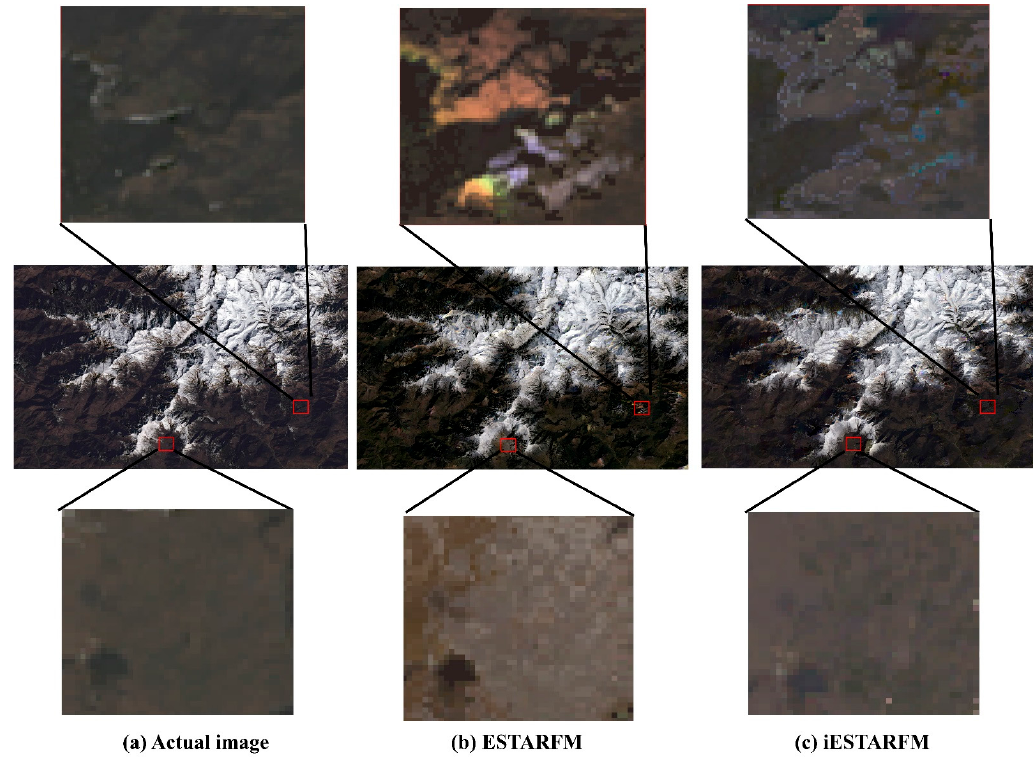
Figure 7. Comparison of the actual and predicted images. ( a ) is the actual image observed on 12 February 2020. ( b ) is the prediction image by ESTARFM. ( c ) is the prediction image by iESTARFM. The images of the first and third rows are the zoom-in areas of three images. From the visual comparison of the overall image, the predicted snow cover bounda- ries of the two methods are similar to those of the actual Landsat image in Figure 7, indi- cating that the two methods can capture the major changes when the snow melts. How- ever, both methods have common limitations, such as a blurring boundary between the snow-covered area and the land area and they also miss some tiny parts of the snow. Fig- ure 7b presents the predicted image of ESTARFM, where bright abnormal patches are generated on the land area due to the wrong selection of similar pixels. The Figure 7c shows the predicted results of iESTARFM, where the over-bright patches and noise are reduced, and clearer texture structures are obtained. Furthermore, comparing the zoom- in area in the first row of the two methods in Figure 7b, it can be seen that bright noise is generated by the ESTARFM method, while iESTARFM can reduce such noise, and the predicted result is closer to the actual image. The third row of Figure 7 presents the areas with significant changes in snow melt. It can be seen that the ESTARFM cannot accurately predict the pixel values which the non-snow pixels are incorrectly predicted as snow. In contrast, iESTARFM is better at predicting the values. The visual comparison results